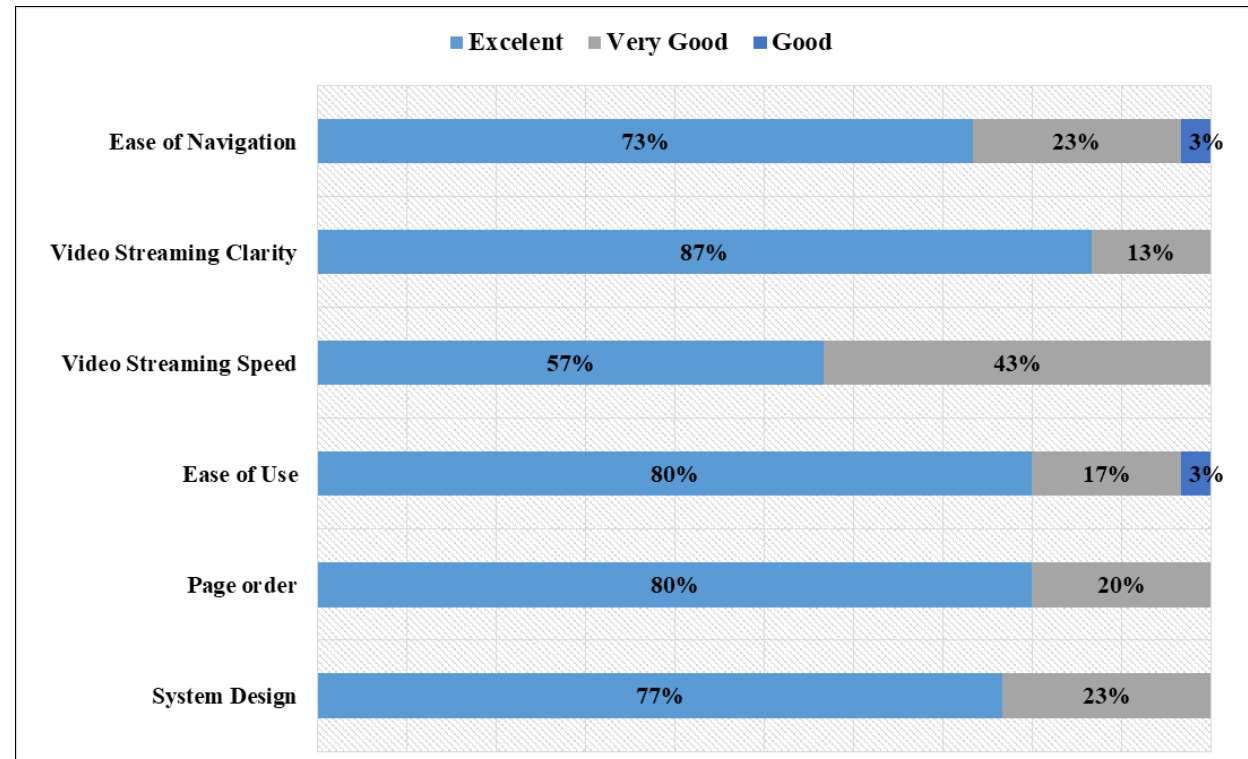
Figure 13. Feedback on mobile system components.